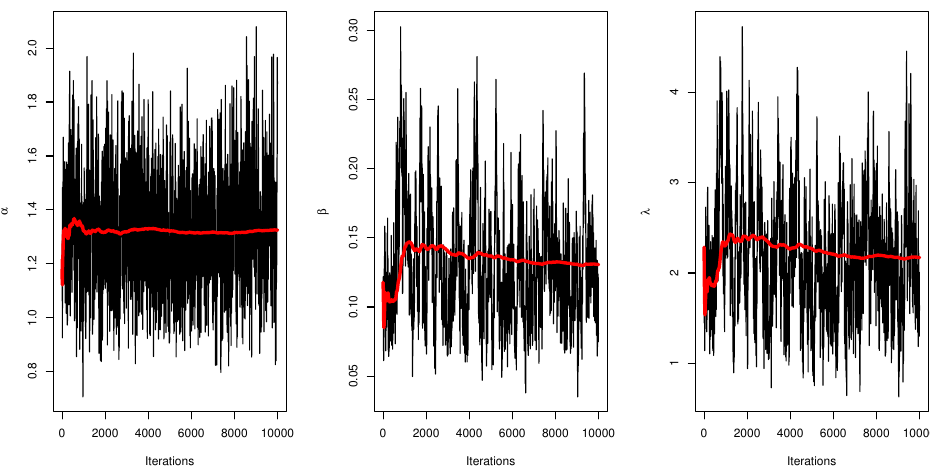
Figure 6. Trace plot of MCMC results for parameters of UEP for the recovery rate of COVID-19 data from Turkey.